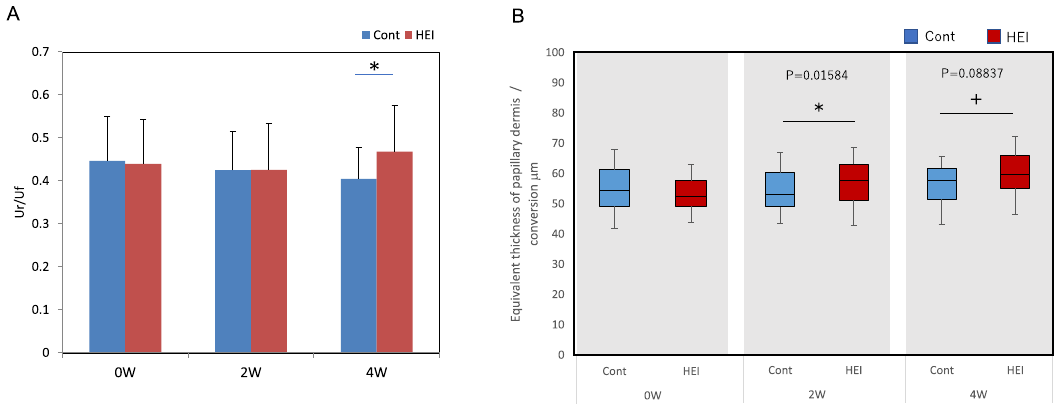
Figure 8. Improving effect of HEI blended lotion on elasticity of facial skin. The skin elasticity was measured with a cutometer, before and after treatment with HEI or with placebo control ( A ). The thickness of the papillary dermis was measured by scanning acoustic microscopy ( B ). *; P <